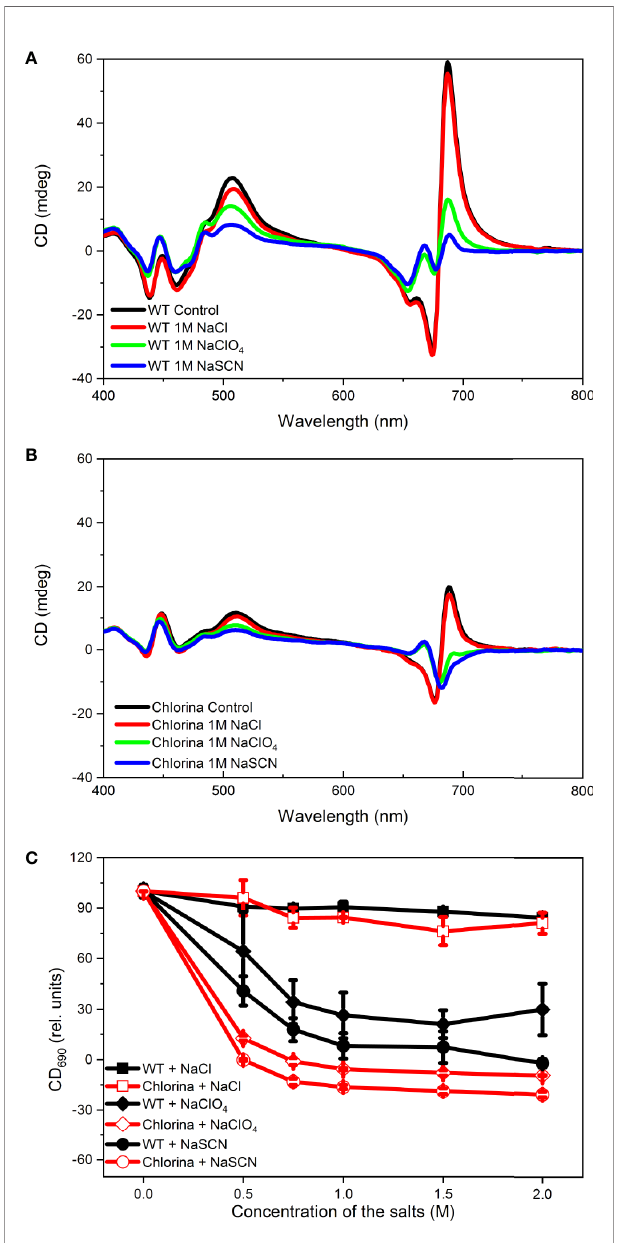
FIGURE 8 | Concentration dependence of the effects of NaCl, NaClO 4 and NaSCN on the CD spectra of WT (A) and Chl-b-less (Chlorina) mutant (B) barley thylakoid membranes. The amplitudes of (+)690 CD y (C) , relative to the untreated control were determined 60 min after the addition of salts. Data points are representing the mean of 5 independent biological replicates ±SD.